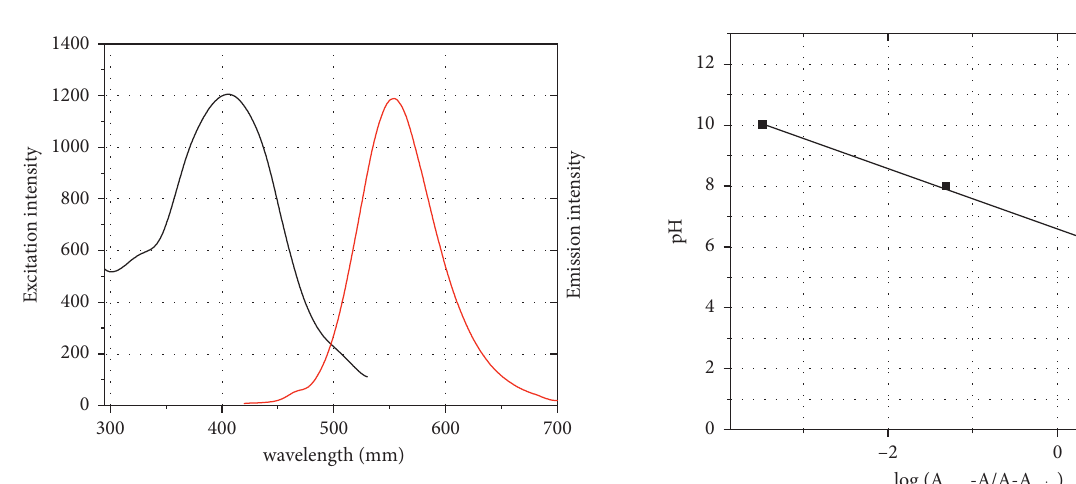
Figure 5: Emission (right; λ � 400nm) and excitation (left; ex Figure 7: Curve demonstrating the fluorescence intensity of λ em � 550nm) spectra of coumarin 3 (1 × 10 − 5 M) in a 10% etha- nolic-universal buffer solution with a pH of 10. coumarin 3 as a function of pH. Measured with coumarin 3 (1 × 10 − 5 M) dissolved in a 10% ethanolic-universal buffer solution ( λ ex � 500nm, λ em � 650nm).